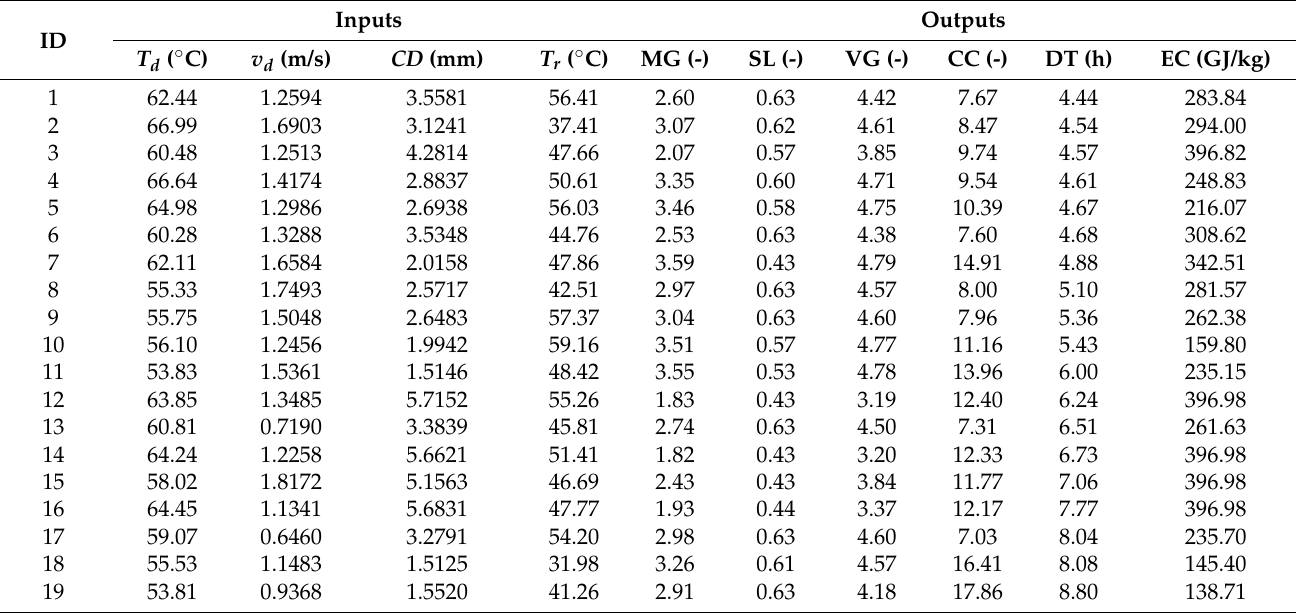
Table 3. Pareto optimal